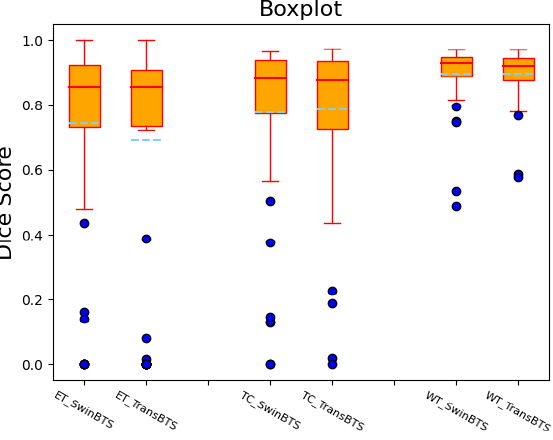
Figure 3. Dice score boxplot of SwinBTS and TransBTS methods on BraTS 2019 test dataset. Table 3. Segmentation results on the BraTS 2020 validation